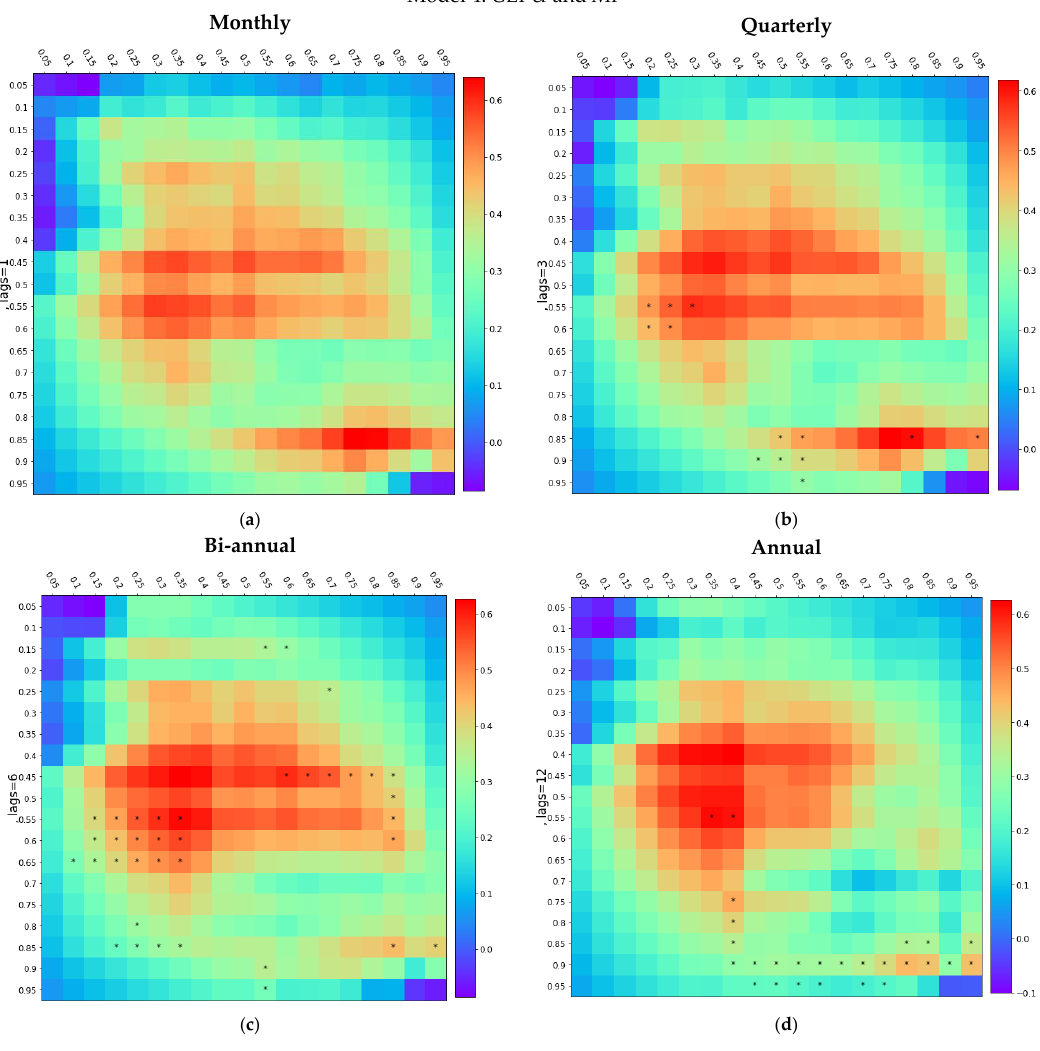
Figure 5. Effect of global economic policy uncertainty ( GEPU ) on mineral import ( MI ) in short (monthly ( a ) and quarterly ( b )), medium (bi-annual) ( c ) and long (annual) ( d ) memories. Notes: * shows the significance level. 0.95 depicts the highest bullish scenario, and 0.05 shows the lowest bearish state for both the GEPU and MI demand. The deep blue spectrum exhibits a solid negative consequence, while the deep red range portrays the strong positive influence of the GEPU on MI . Besides, light green and red colors display a moderately positive relationship between GEPU and MI